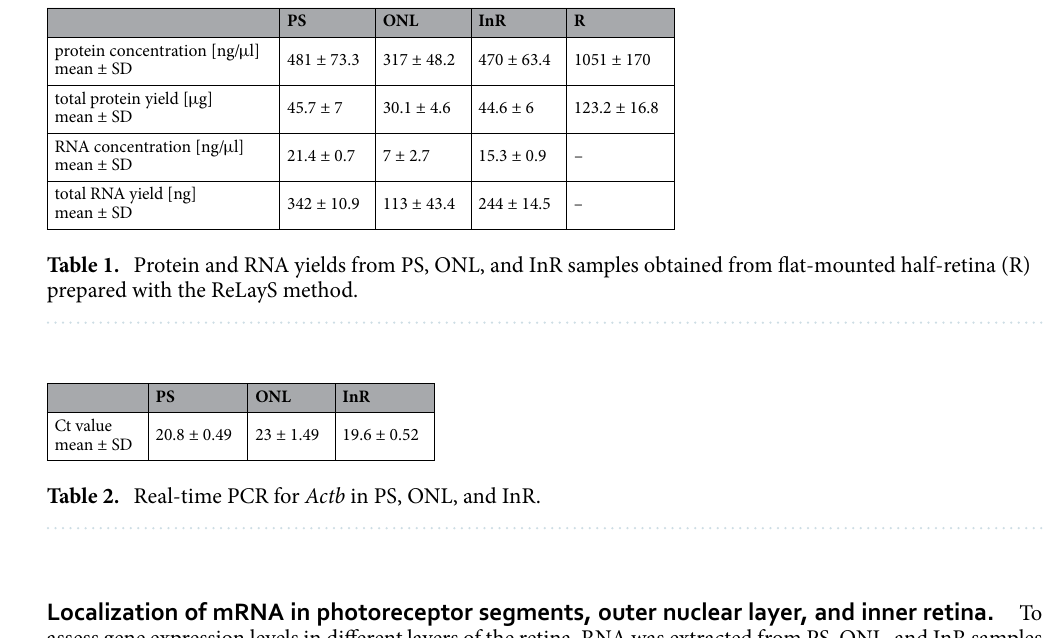
Localization of mRNA in photoreceptor segments, outer nuclear layer, and inner retina. To assess gene expression levels in different layers of the retina, RNA was extracted from PS, ONL, and InR samples obtained from single half-retinas. For RNA quality control, microcapillary electrophoretic RNA separation was performed and RNA integrity number (RIN) was calculated 28 (Figs. 5a and S4). RIN ranged between 7.0 and 8.0 for PS, ONL, and InR samples obtained with the ReLayS method, indicating low levels of RNA degradation. Since the samples originate from different cellular compartments and different cell types, it is extremely dif- ficult, if not impossible, to determine reliable housekeeping genes for quantification of relative expression levels between the three different ReLayS fractions. This was exemplified by the Ct values for actin-beta ( Actb ) that variate considerably between the PS, ONL and InR samples (Table 2), making Actb not suitable as a reference housekeeping gene. Therefore, real-time PCR experiments were always performed with 10 ng of cDNA template and Ct values were plotted instead of relative expression values. Ideally, however, expression levels should be determined by absolute quantification methods such as digital PCR. As for the proteins, we analysed the expression levels of six genes with known profiles within the retina 29 (Fig. 5b,c). Expression of the rod photoreceptor-specific gene rhodopsin ( Rho ) was detected in the PS and ONL, but to lower levels also in the InR samples. Aquaporin-4 ( Aqp4 ) mRNA, a water-specific channel expressed in Müller glia cells 30 , was detected in the ONL and InR samples (Fig. 5c), similar to Slc2a3 encoding the glucose transporter GLUT-3, which is expressed by inner retinal cells 31 . The amacrine cell-specific gene myogenic factor 6 Myf6 was also detected predominantly in the InR samples and to lower levels in the ONL (Fig. 5c). Finally, expres- sion of the smooth muscle cell-specific actin Acta2 and the ganglion cell-specific transcription factor Pou4f1 21 was highly enriched in the InR samples containing the retinal vessels and the ganglion cells. These data indicate a good separation of the layers by ReLayS but with some contamination of the ONL with genes expressed in the